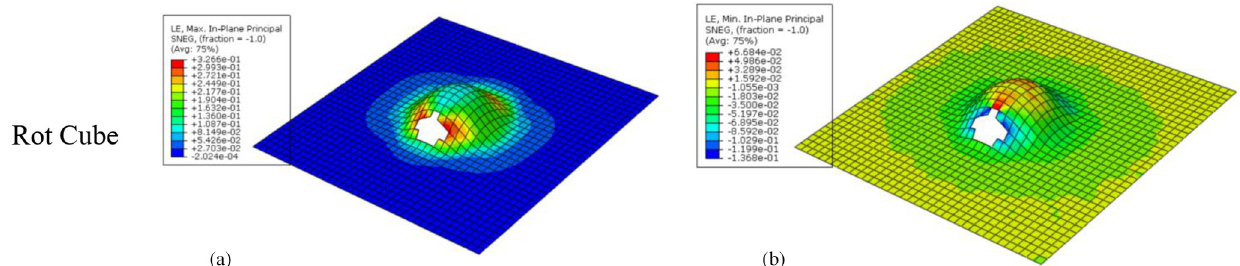
Fig. 12. (a) Maximum in-plane principle strain under biaxial stretching. (b) Minimum in-plane principle strain under biaxial stretching.